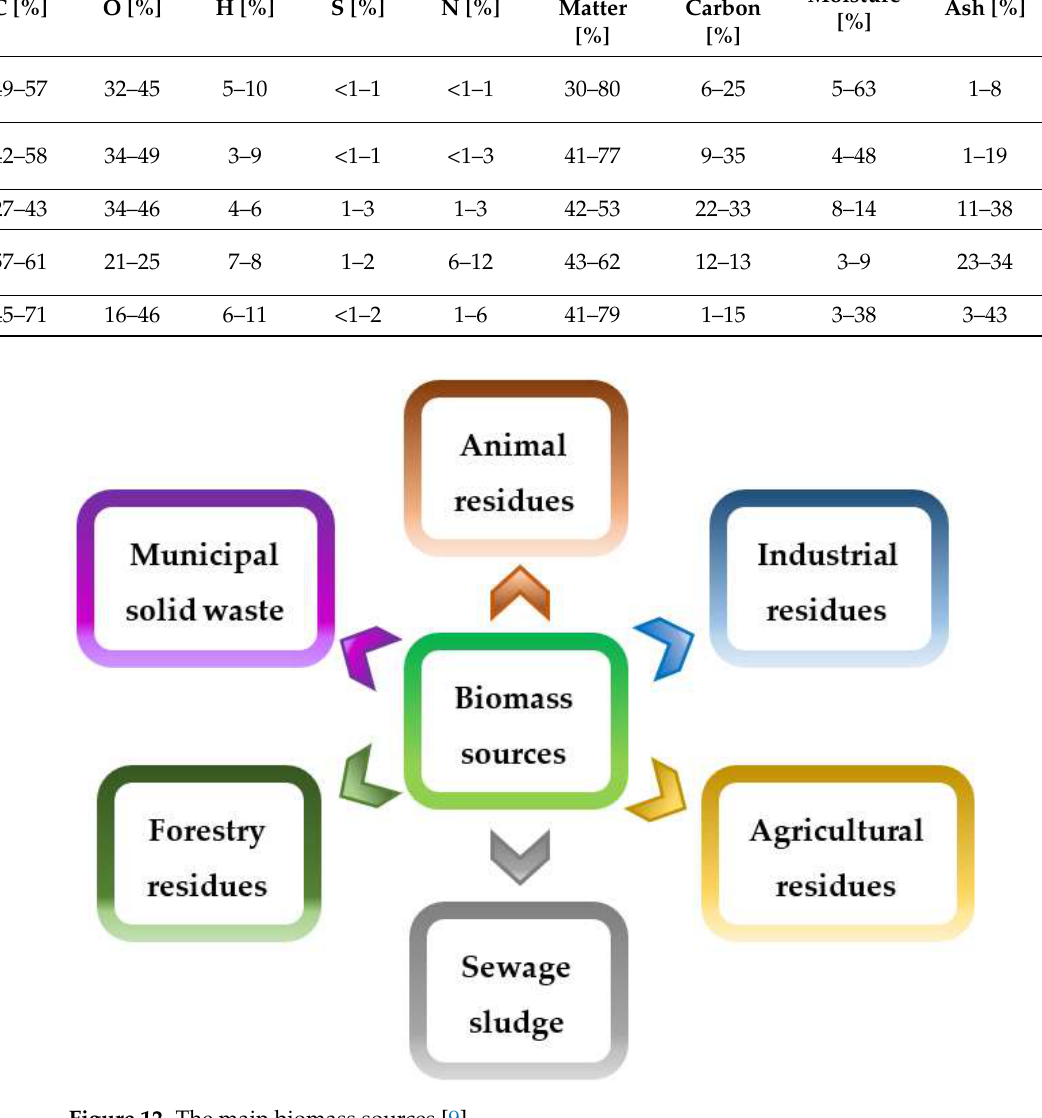
Figure 12. The main biomass sources [9].